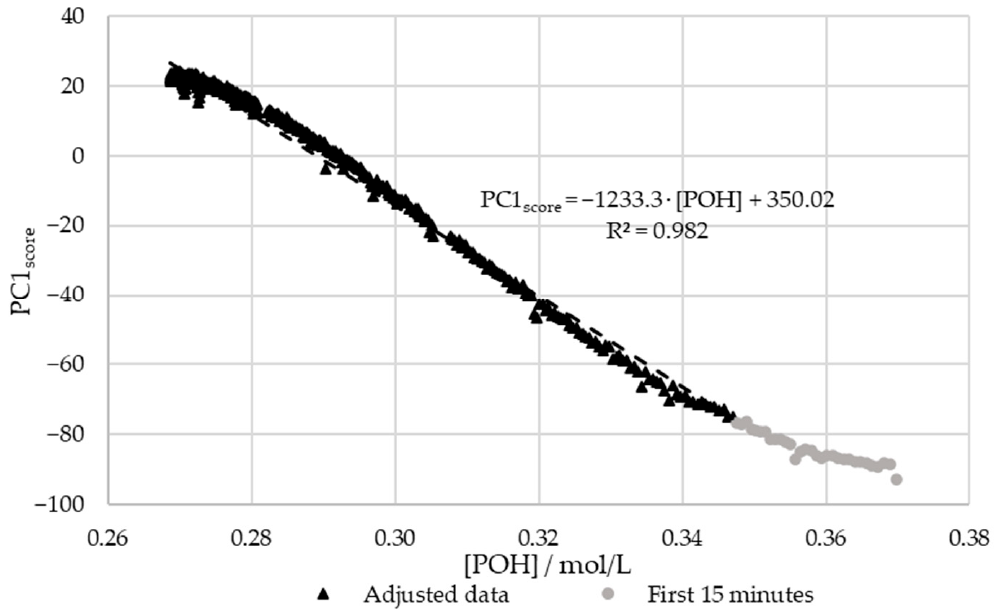
Figure 12. PC1 score vs. the decay of phenolic groups type I and II for the methylolation of the SLS